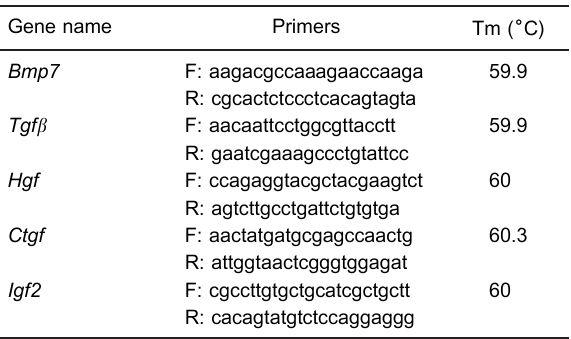
Table 3 . Primers for detecting kidney